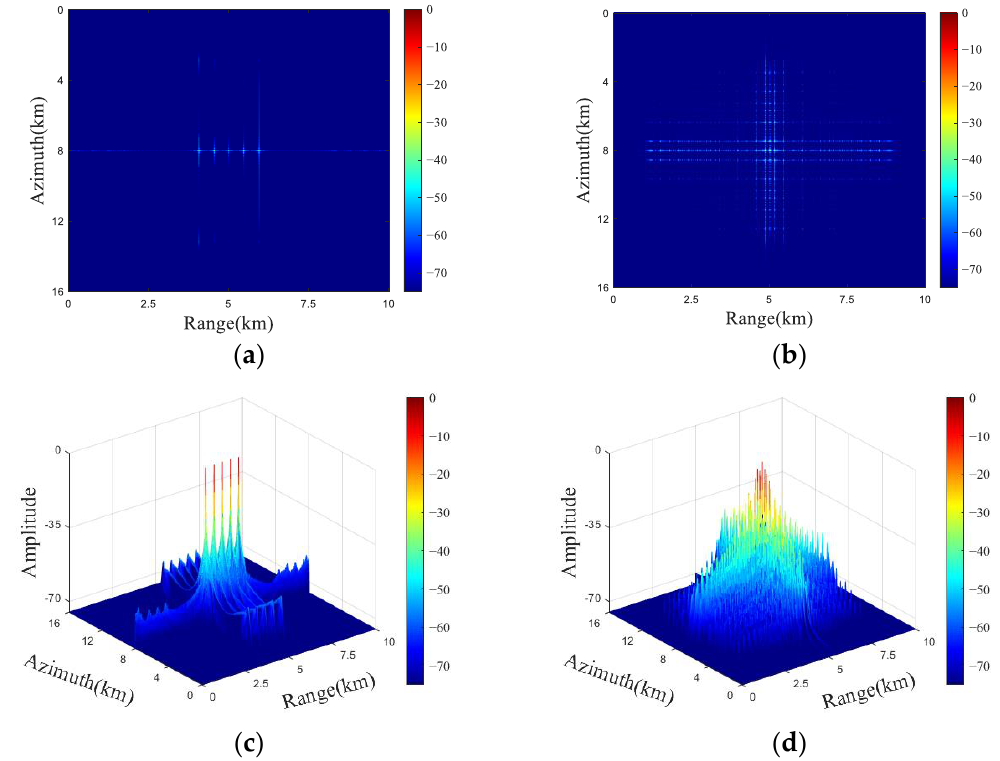
Figure 12. Simulation results of point targets with ( a ) the FDA-based jamming and ( b ) the ISRJ. ( c ) and ( d ) are the 3D imaging results of ( a ) and ( b ), respectively.